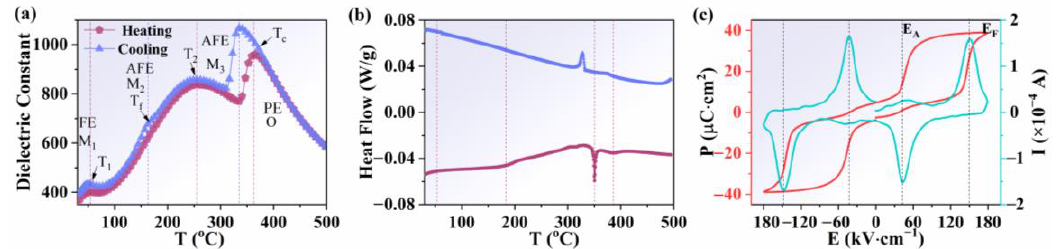
Figure 2. ( a ) Temperature dependence of the dielectric constant for AgNbO 3 ceramics. ( b ) DSC curves of AgNbO 3 ceramics on heating and cooling. ( c ) P-E and I - E loops of AgNbO 3 ceramics at room temperature.